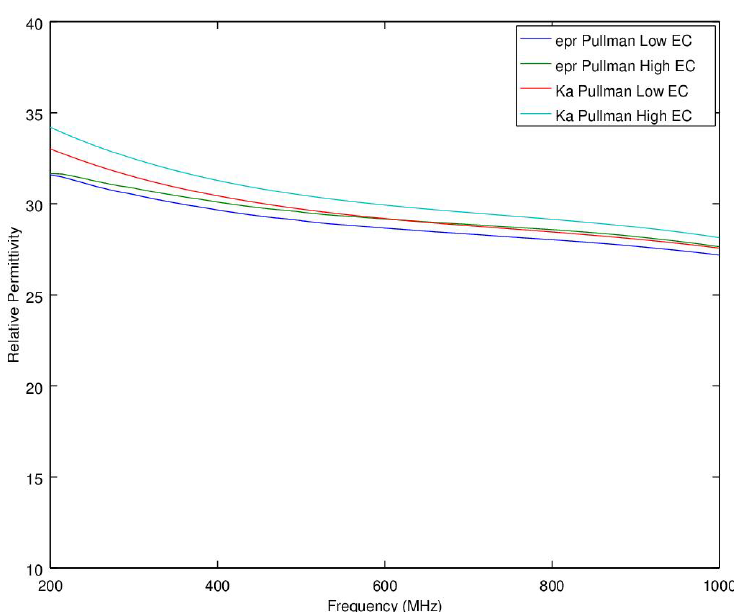
Figure 6. This is a chart of measurement results utilizing the new probe design with a column filled with a saturated Pullman clay loam at low and at high electrical conductivities (EC). The measurement is of the transmission loss (S21) for Pullman clay loam and contrasts the relation between Ka and dielectric constant. Legend: epr (relative dielectric constant, ε′ ).